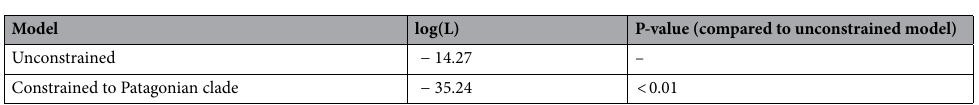
Table 3. Likelihood ratio test conducted for constrained and unconstrained type position to the Patagonian clade.